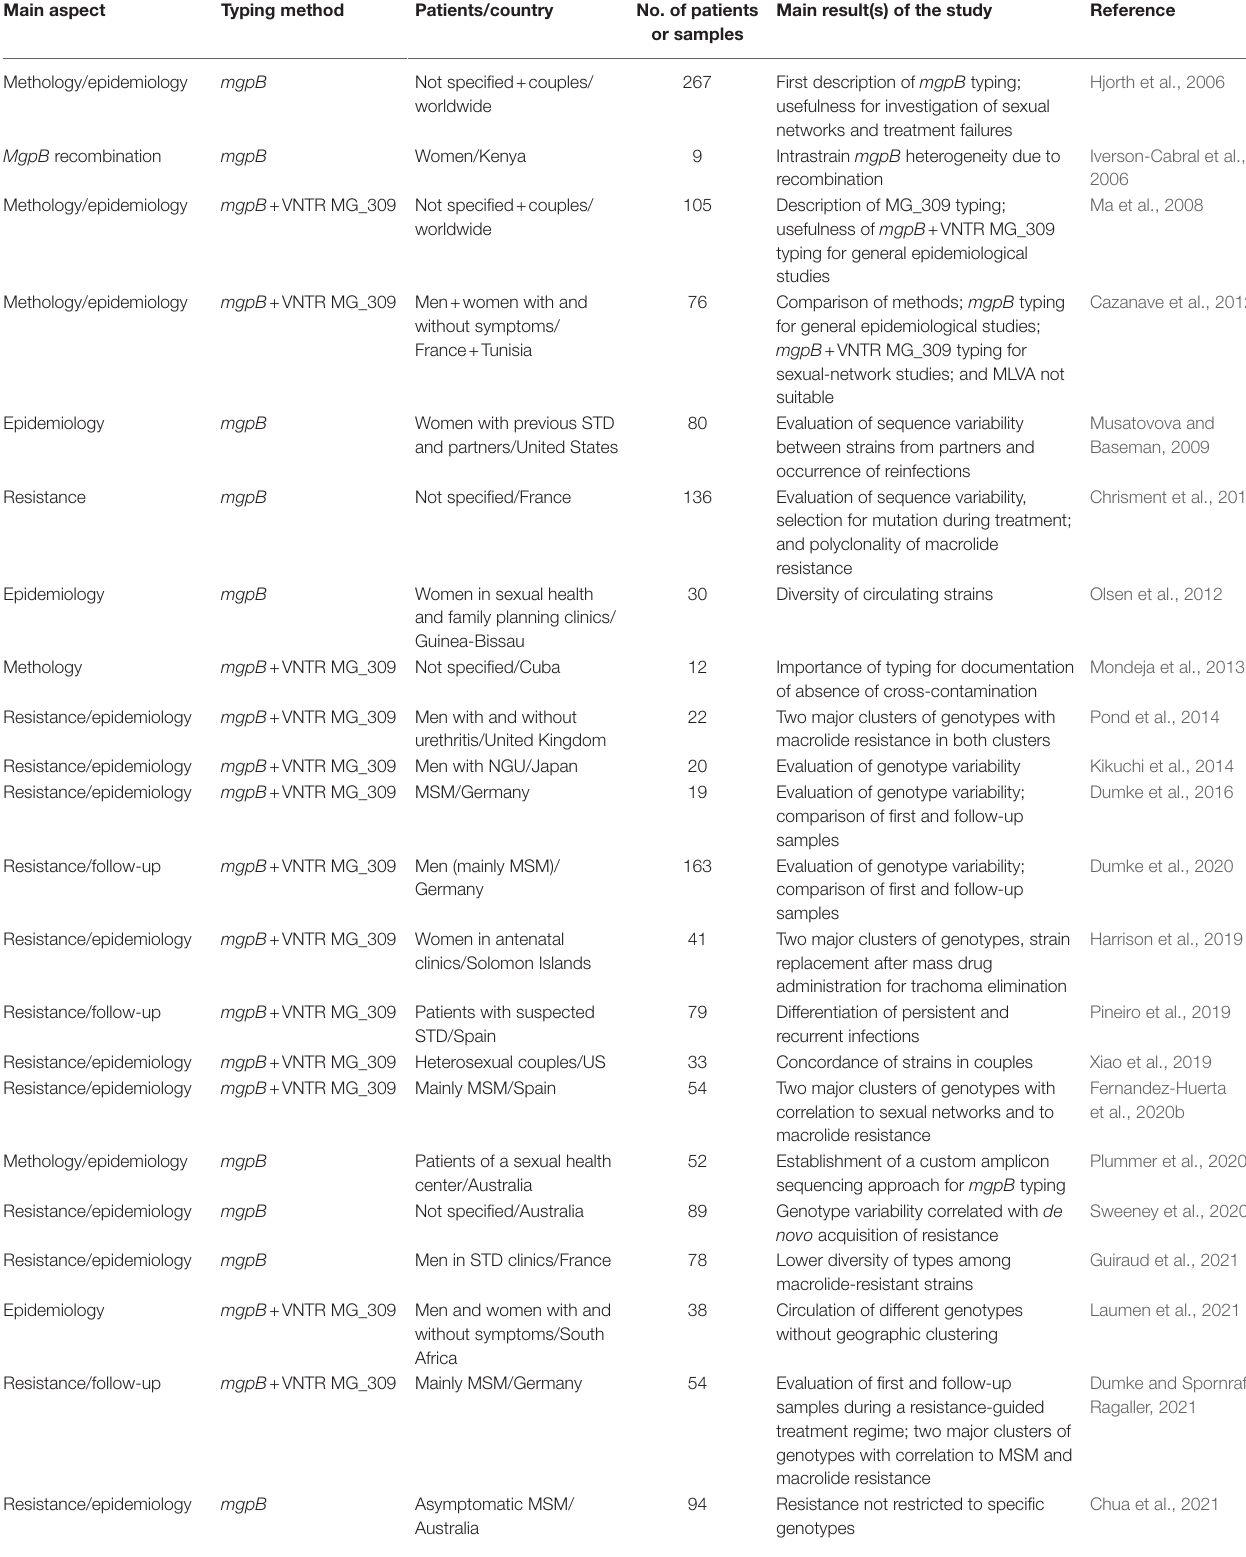
TABLE 2 | Results of Mycoplasma genitalium typing